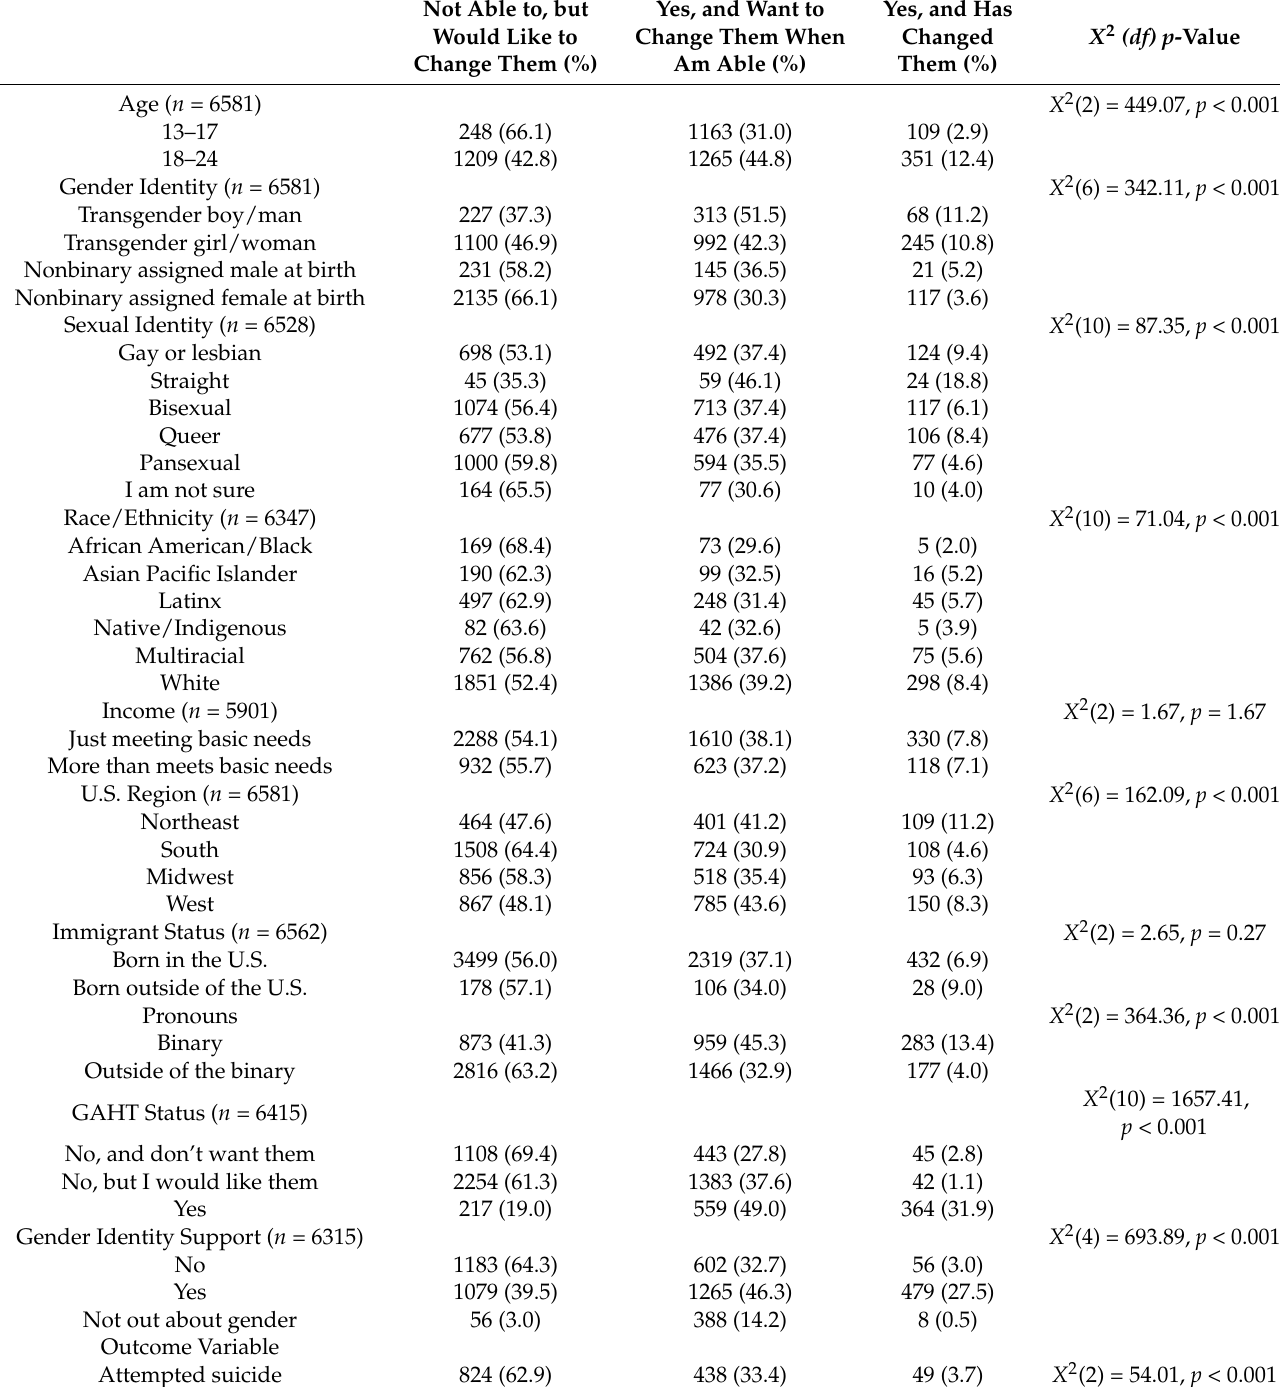
Table 1. Sample characteristics stratified by official document change